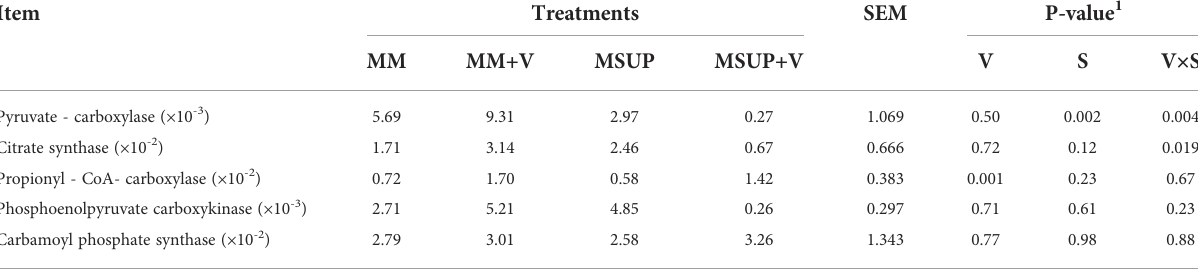
TABLE 8 Effects of feeding multiple supplement and, or virginiamycin on the hepatic gene expression of some key enzymes of energy metabolism and urea cycle of heifers fed a high-quality tropical forage.